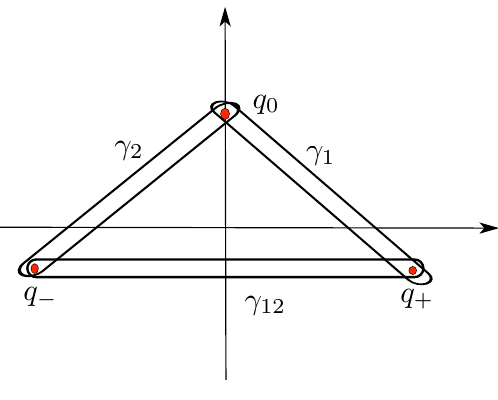
Figure 7 . The WKB cycles for the PT-symmetric cubic oscillator with Hamiltonian (4.8). has three turning points: one of them, q 0 , is in the imaginary axis, while the other two, denoted by q (cid:6) , are in the fourth and the third quadrant of the complex plane,